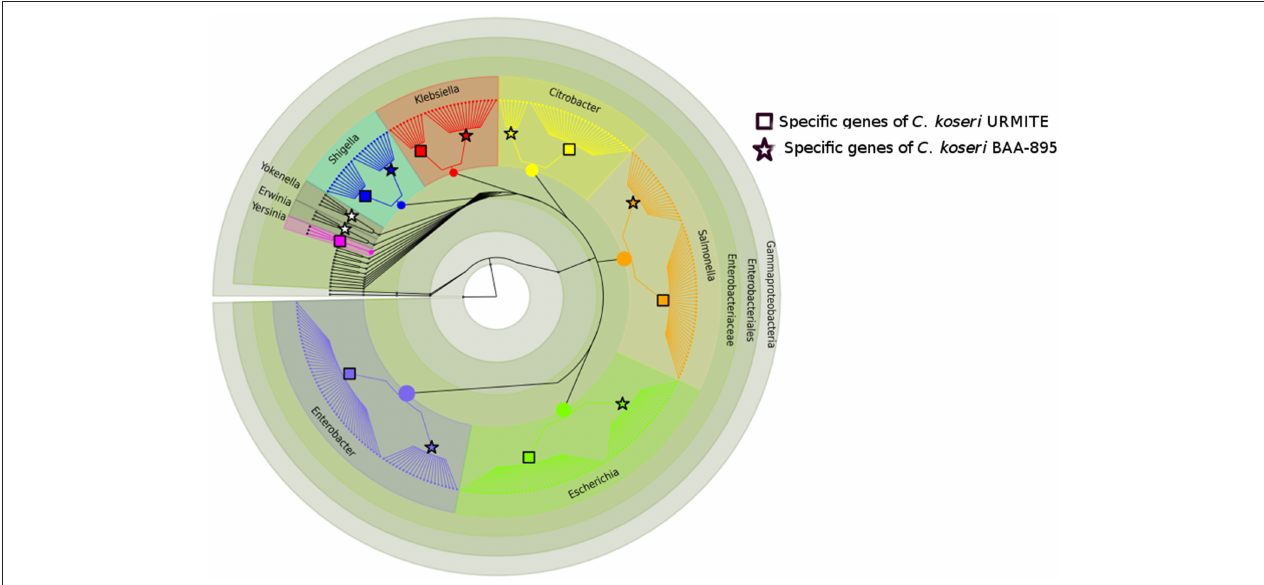
FIGURE 3 | Phylogeny of strain-specific genes. The figure indicates the probable phylogenetic origin of the strain-specific genes at the genus level. The C. koseri URMITE and C. koseri ATCC BAA-895 specific genes are shown by square and star markers, respectively. The gene phylogeny with low branch supports or unresolved were not shown. The flow of gene exchange mainly involved Enterobacteriaceae spp.